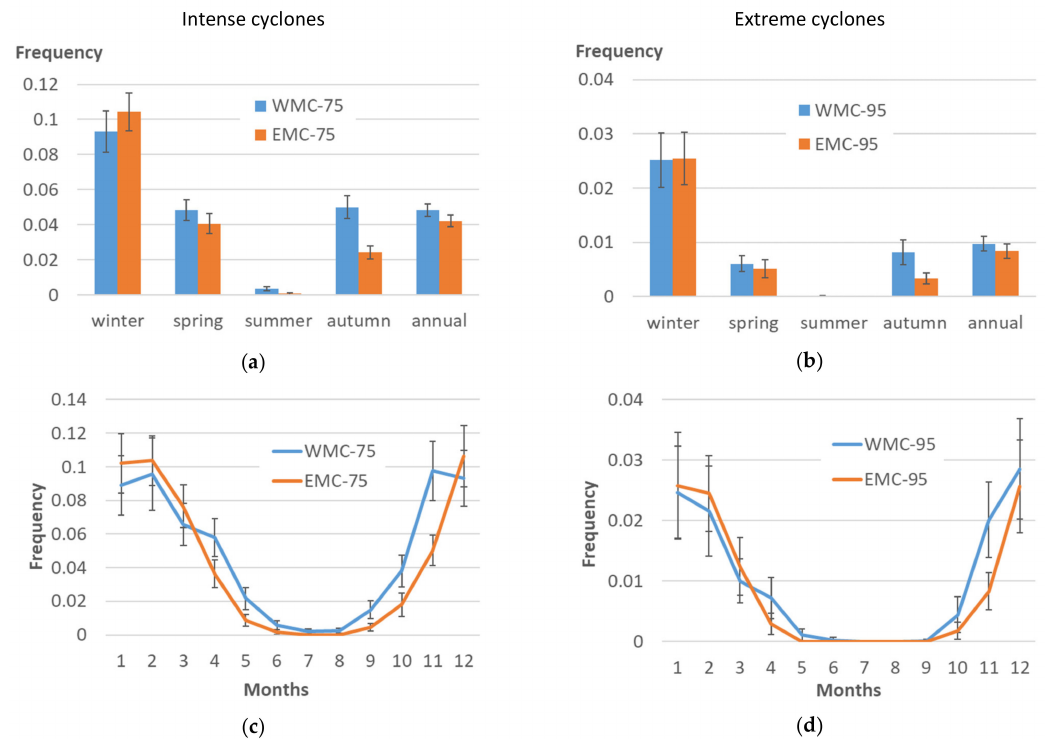
Figure 3. Seasonal/annual ( a , b ) and monthly ( c , d ) averages of the frequency of intense/extreme cyclones over the Western and Eastern Mediterranean (WMC-75/WMC-95 and EMC-75/EMC-95, respectively): ( a , c ) intense cyclones; ( b , d ) extreme cyclones. Error bars correspond to the 95% confidence